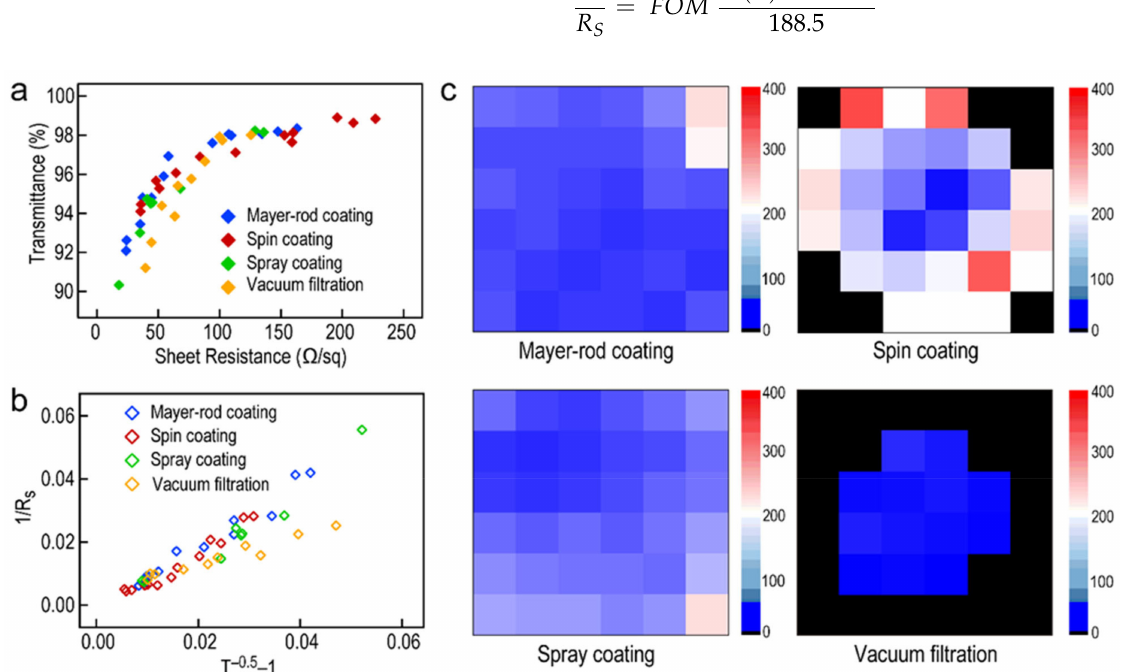
Figure 4. ( a ) Plots of optical transmittance ( λ = 550 nm) versus sheet resistance for Ag NW-based films by four methods. ( b ) Plots of 1/ R s as a function of ( T( λ ) − 0.5 − 1) for these four films. ( c ) Sheet resistance maps of Ag NW-based films fabricated by Mayer-rod method (6 × 6 cm 2 ), spin coating method (6 × 6 cm 2 ), spray coating method (6 × 6 cm 2 ), and vacuum filtration method (4 × 4 cm 2 ),